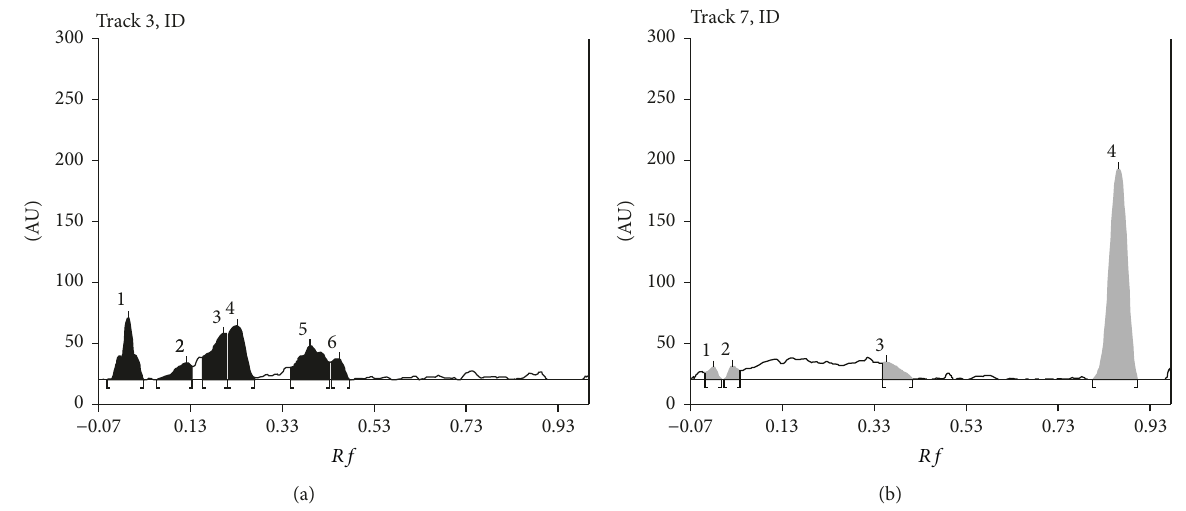
= 200 nm; 𝑅 = 0.88 𝐹 max